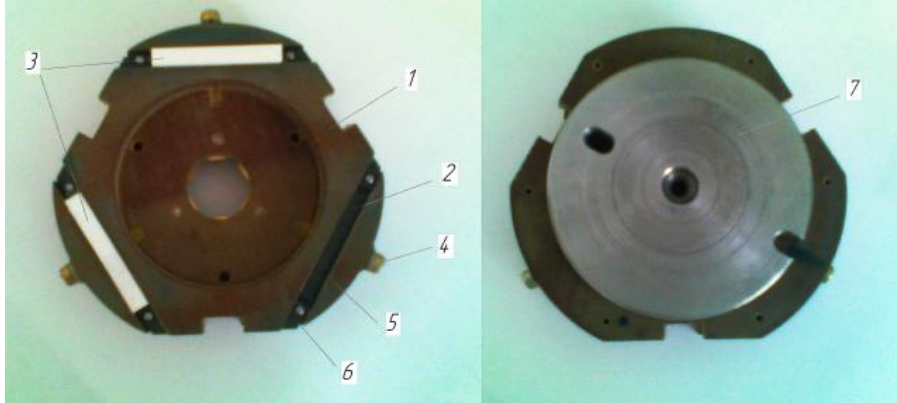
Figure 2. Device for processing ceramic samples. 1—body, 2—grooves, 3—machined parts, 4—screw, 5—clamp, 6—elastic limiters, 7—washer